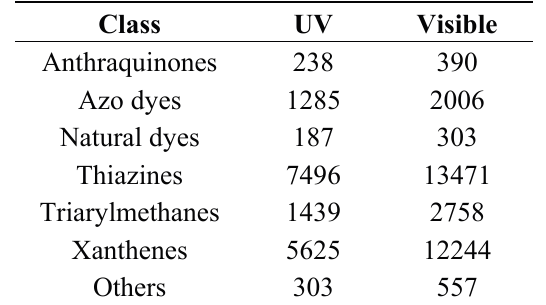
Table 1. An estimation regarding the number of publications on the photocatalytic degradation of dyes under UV light and under visible light, organized according to dye categories. The estimation is based on SciFinder TM data source, taking the